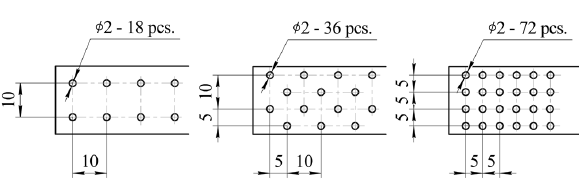
Fig. 2. The layout of the vertical reinforcing rods in the mold model: a – double row; b – diagonal; c – four row